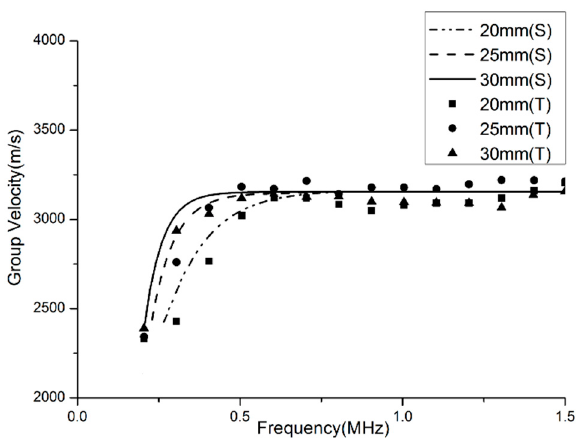
Figure 13. Comparison of group velocity dispersion curves between simulation and test; Notes: S—simulation data; T—testing data.